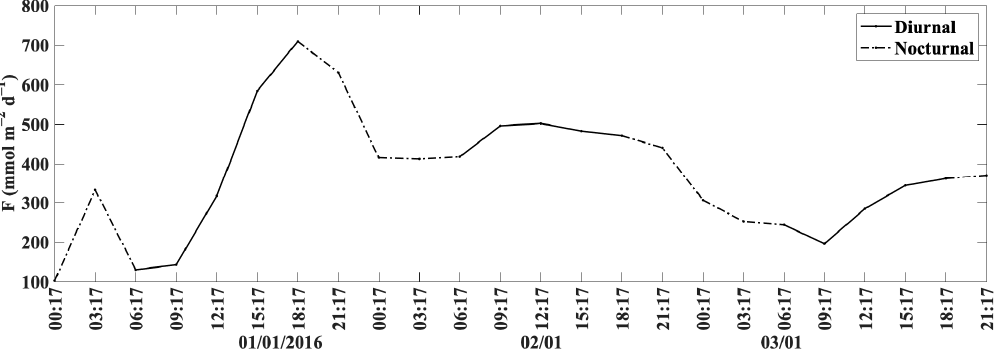
Figure 4. Sea–air CO 2 flux at station Kodiak (152°W, 57°N) from January 1 to 3, 2016. Diurnal hours are 06:00, 09:00, 12:00, and 15:00, and nocturnal hours are 18:00, 21:00, 00:00, and 03:00.